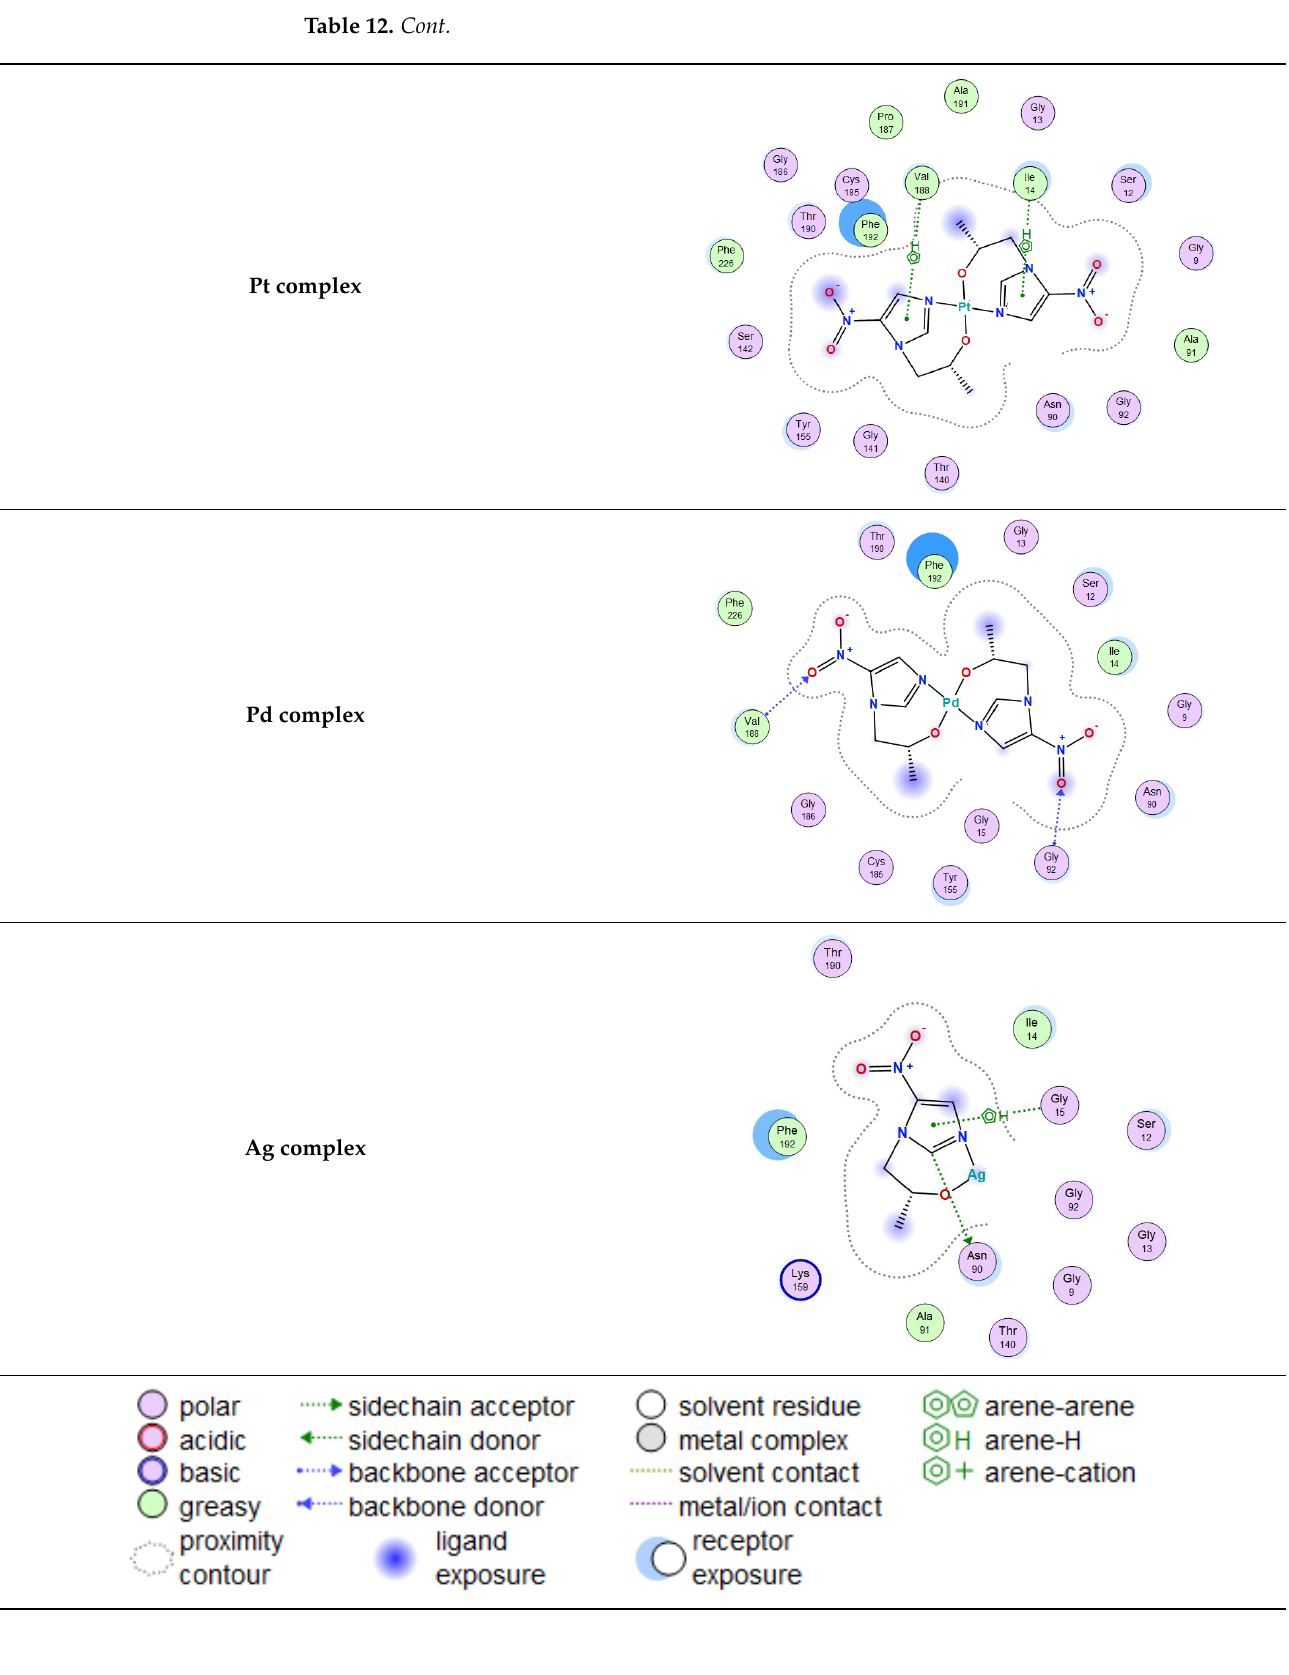
Table 13. 3D and site interaction of the ligand and its metal complexes with 3hb5 protein.